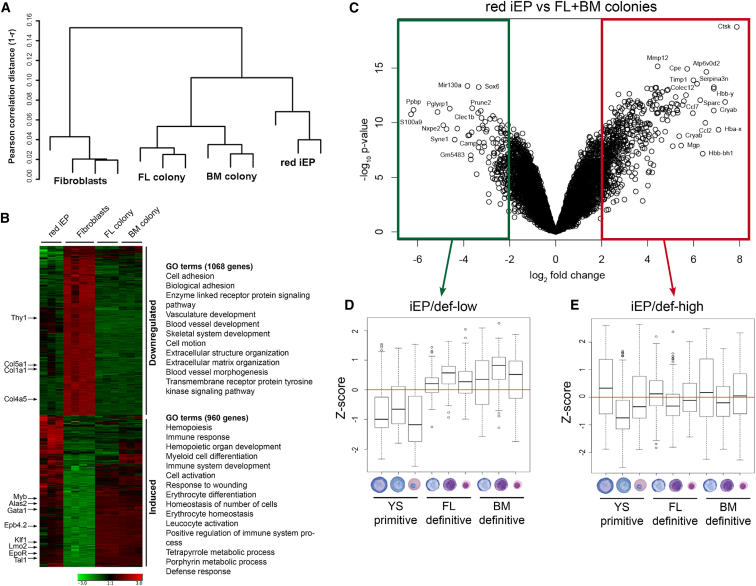
iEP-Derived Red Colonies Retain a Primitive Erythroblast Expression Signature(A) Unsupervised clustering of samples included in microarray analysis: cultured TTFs (fibroblasts), E14.5 fetal liver BFU-Es (FL colony), adult bone marrow BFU-Es (BM colony), and iEP-derived red colonies (red iEP).(B) Heatmap depicting genes with ± 2 log2 fold differential expression between red iEPs and fibroblasts. Downregulated and induced gene clusters are highlighted with their most representative GO terms (p ≤ 10−10) according to DAVID (Huang et al., 2009a, Huang et al., 2009b).(C) Volcano plot presenting differentially expressed genes between red iEPs and bona fide BFU-Es (FL and BM BFU-Es). The log2 fold difference is plotted on the x axis, and the p value-adjusted significance is plotted on the y axis (–log10 scale).(D and E) Genes with at least 4-fold higher expression in bona fide BFU-Es than in red iEPs (iEP/def-low) and genes with at least 4-fold higher expression in red iEPs than in bona fide BFU-Es (iEP/def-high) were searched in the publicly available Erythron database (Kingsley et al., 2013). Box plots show the average expression of selected iEP/def-low (D) and iEP/def-high (E) genes in YS primitive, FL-definitive and BM-definitive erythroid cells at different stages of maturation. Pictures were taken with permission from Erythron DB (EMBL-EBI: E-MTAB-1035).See also Figure S3.